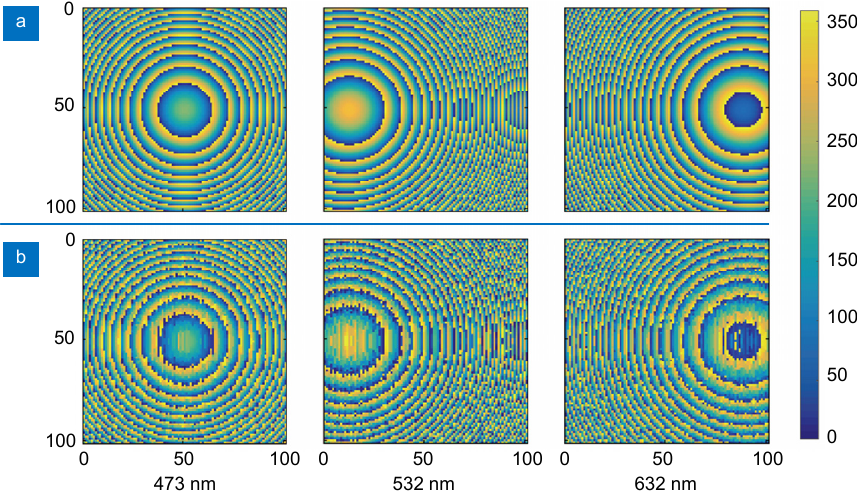
Fig. 3 | Comparison between the target phase profiles (a) and optimized results (b) at three wavelengths of 473 nm (left), 532 nm (mid- dle), and 632 nm (right). The designed metasurface consists of 101×101 pixels. Abscissa and ordinate indicate the number of